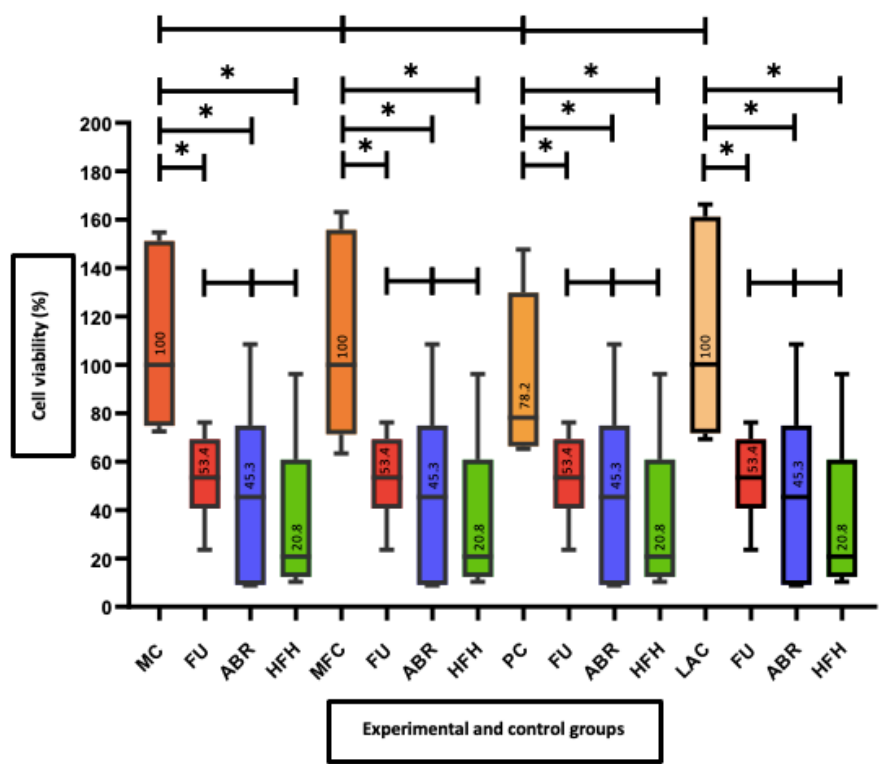
Figure 4. Comparison of cell viability (%) of experimental and control groups. Cell viability was expressed as a percentage of medium control group cell cultures. Results of Kruskal–Wallis test and Mann–Whitney U test. *: Indicates statistically significant differences in cell viability ( p < 0.05). MC: